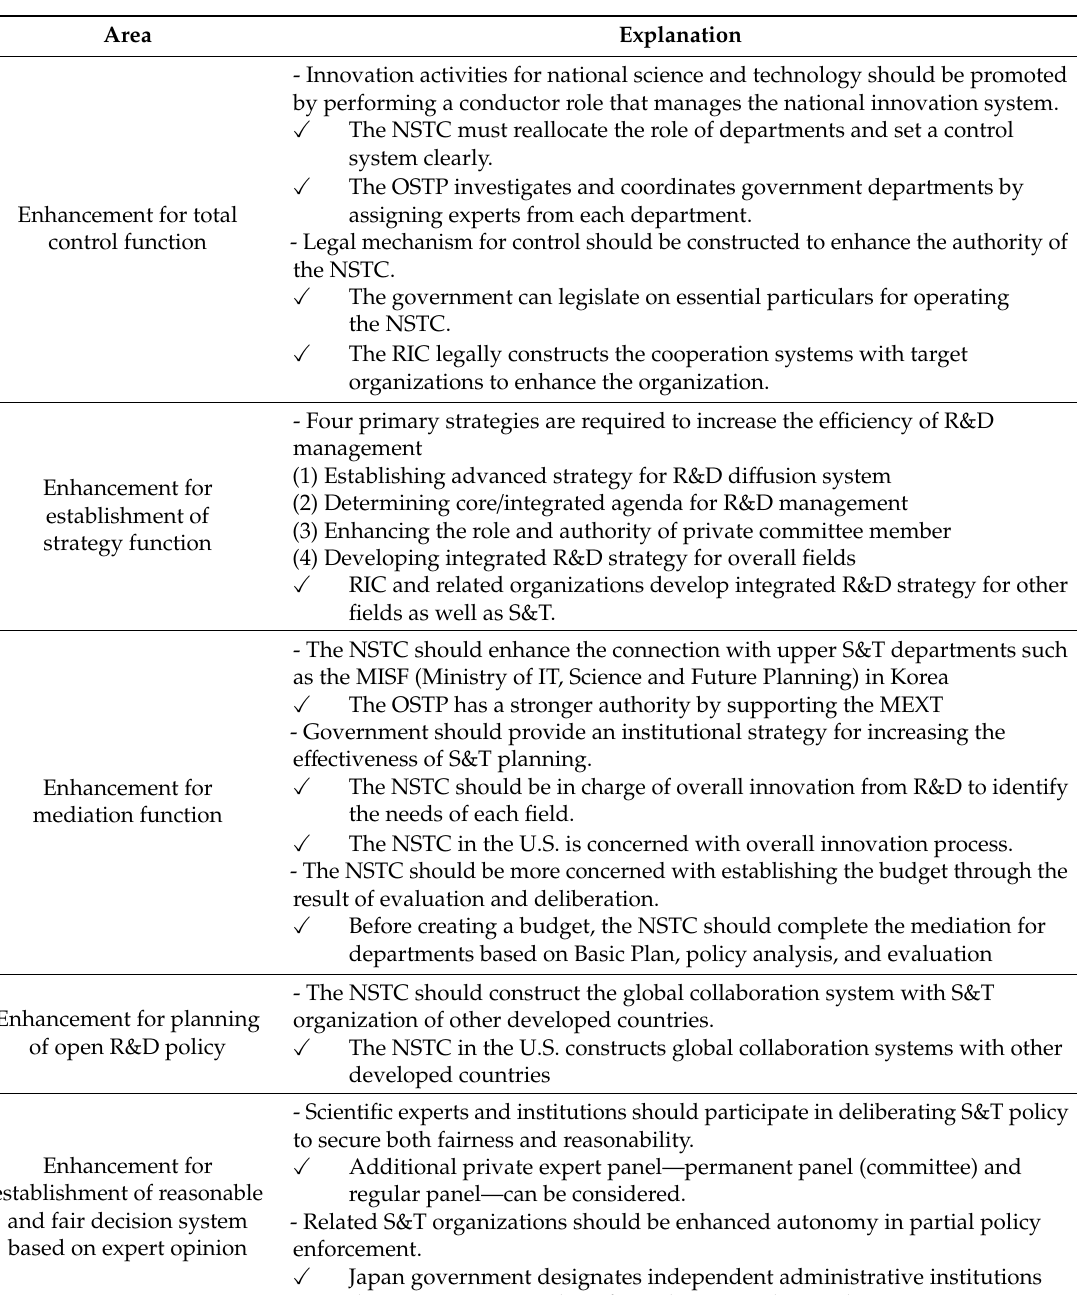
Table 6. Basic directions for enhancement of